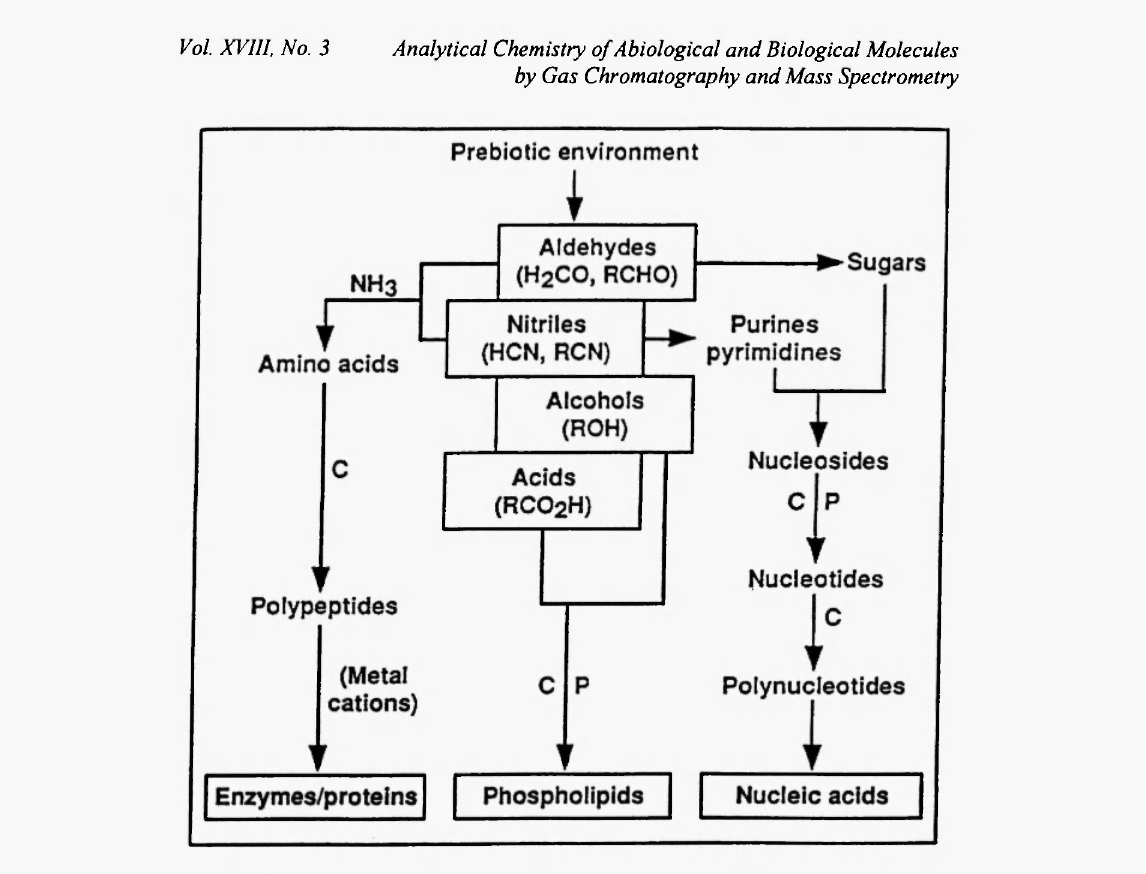
Fig: 1: is an outline of the possible routes of abiological synthesis of biomolecules. HCN and CH 2 0 are important precursor molecules necessary for the formation of simple biomolecules. The symbol C, signifies that condensing agents are important for the formation of macromolecules. The requirement for inorganic phosphate is indicated by 'P' (reprinted from S. Chang, 1993, ref. 1201, with kind permission from Kluwer Academic